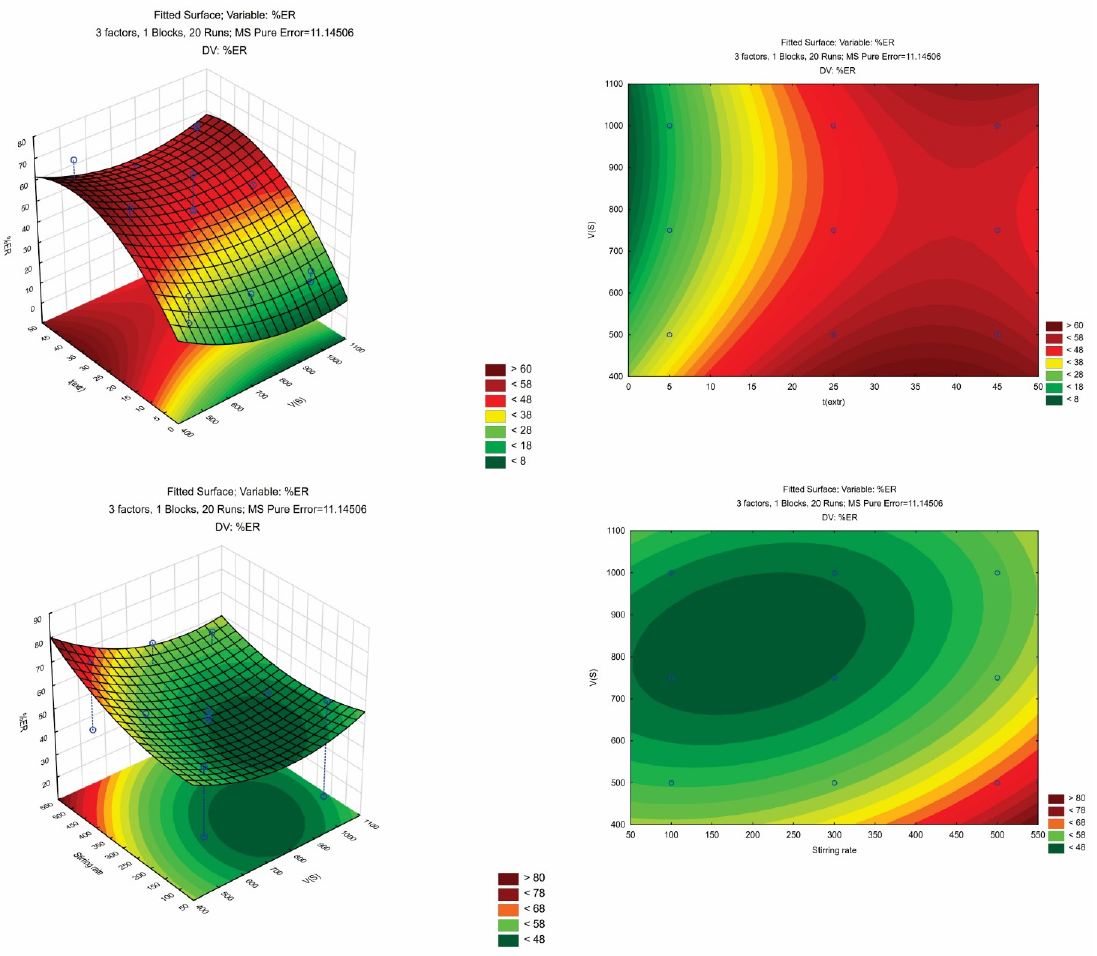
Figure 2. 3D and contour plots illustrating the effects of V S , t ext. , and stirring rate on the%ER of AMB. Derringer’s desirability function (D) was used (scaled between 0 to 1) as a fully de- Table 1. Experimental FC-CCD domain for the optimization of CPME sirable response, aiming to find the optimal CPME conditions. The desirability graphs and the prediction profiles are shown in Figure 3. The optimum conditions were 500 μ L for V s , 25 min for t ext. , and 500 rpm for the stirring rate. Finally, six repetitive extractions were carried out under optimum conditions for their confirmation. The differences between the predicted values and the obtained values from the set of experiments were <7%.